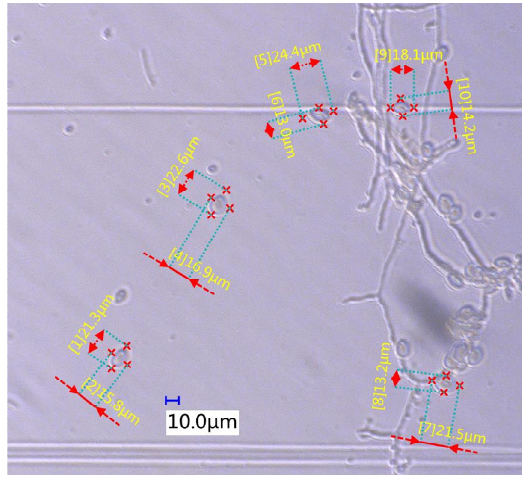
Figure 1. The measurement results for B. cinerea spores.